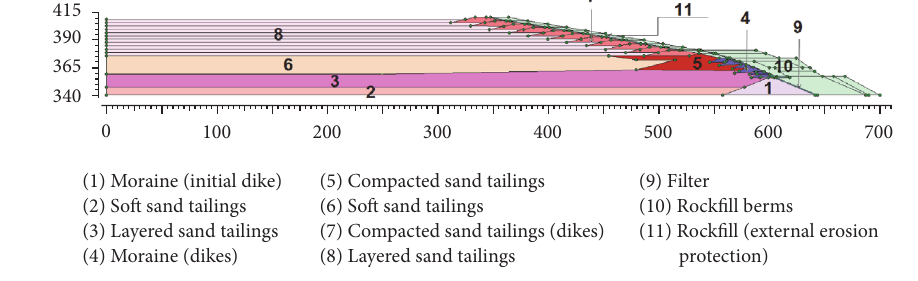
Figure 3: Finite element model of dam E-F. Dimensions are in meters.